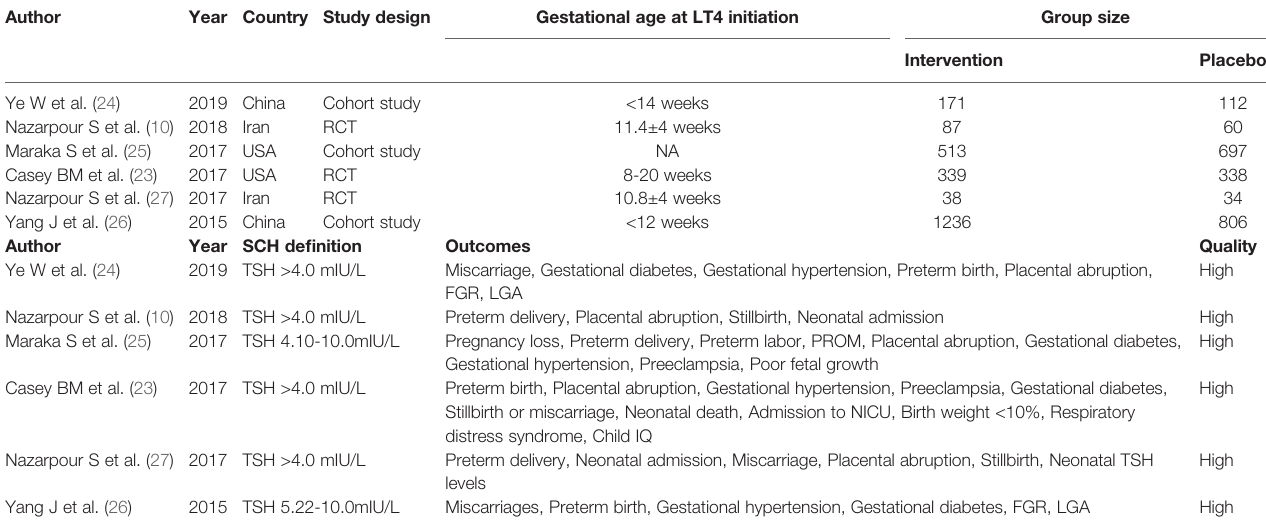
TABLE 1 | Characteristics of the included